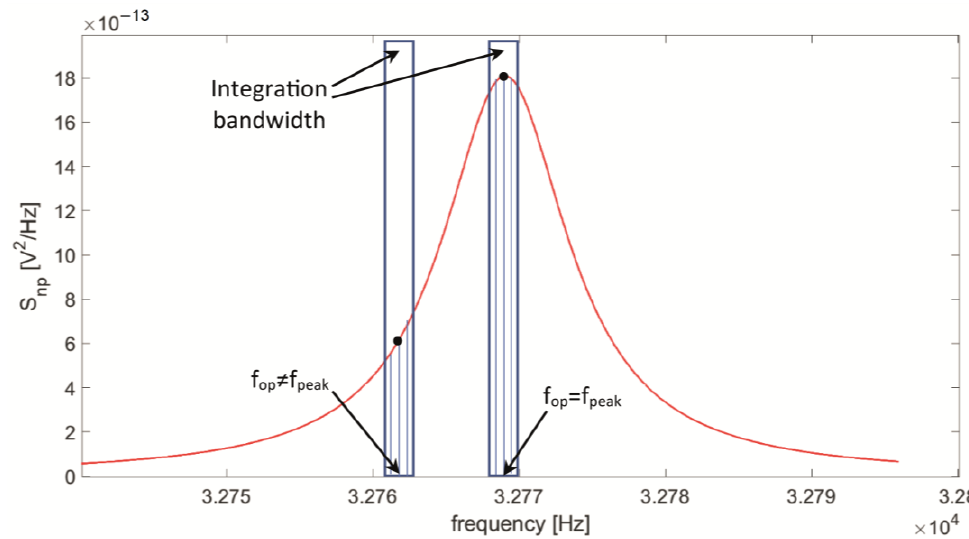
Figure 13. Integration of the contribution S np (red line), due to R P , to the total output spectral noise density at a low-pass filter bandwidth of 0.5 Hz around the operating frequency f op , for f op = f peak and f op ≠ f peak (R L = 100 k Ω ).